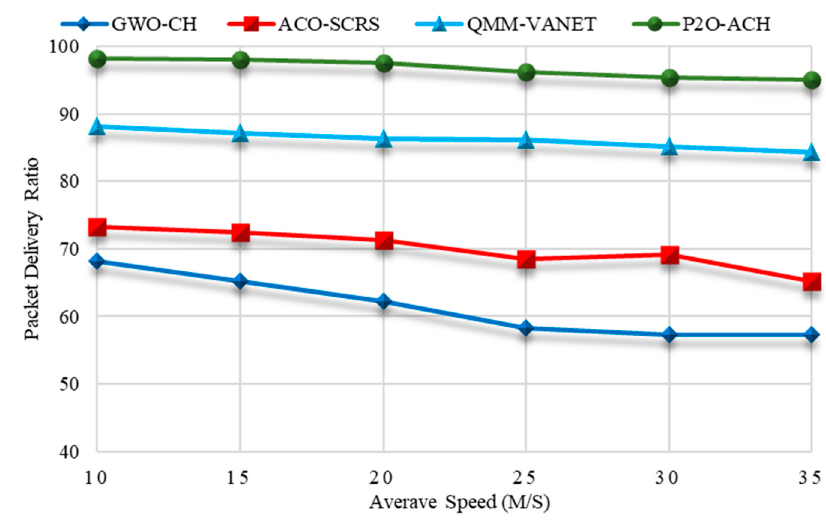
Figure 14. Packet Delivery Ratio Calculation.